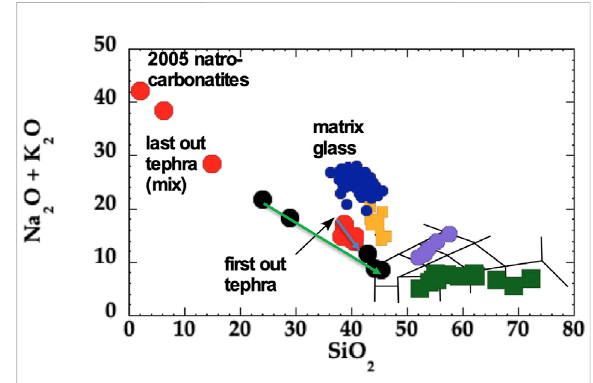
FIGURE 8 Totalalkalisvs.silica(TAS)diagramexpandedtofullSiO 2 scale and to very high total alkali contents showing the observed trends ineruptedODLsamples(redcircles)andtheODL-5wkexperiment (black circles). The fi rst out tephra of the zoned nephelinite eruption of 2008 is marked with black arrow. Subsequently erupted less differentiated and more silicic samples trend down andtotherightfollowingthetrendofthebluearrow.Notethatthe very last erupted tephra re fl ects a mix of carbonatite and nephelinite (thus is not representative of the decreasing silica differentiation trend). The two highest Na 2 O+K 2 O/lowest SiO 2 samples from ODL are the 2005 natrocarbonatite and 2007 tephra, show for reference. Sub-samples from the ODL-5wk experiment are shown as black circles. The lowest temperature sub-sample starts at Na 2 O+K 2 O=22 and sub-samples from progressively hotter levels in the experiment follow the green arrow trend. Thus, there is general correspondence of the down- temperature trend of differentiation observed in the ODL zoned eruptionandtheODL-5wkexperiment.AlsoshownareotherODL nephelinites (gold squares: Klaudius and Keller, 2006) and ODL 2008 matrix glasses (blue circles: de Moor et al., 2013). For reference, green squares are sub-samples from the Huang et al. (2009) thermal migration experiment involving wet andesite that reproduces Earth ’ s calc-alkaline differentiation trends to silicic compositions. An alkalic differentiation trend is shown by the purplecircles(datafromtheMasottaetal.(2011)thermalmigration of phonolite experiment). Thus, igneous differentiation in the shallow crust could re fl ect a similar thermal gradient-based differentiation process operating on different compositions with total alkalis playing the decisive role in the trajectory of silica changes during